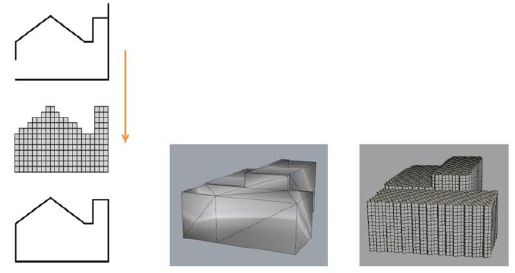
Figure 2 . The voxelization repair concept for 3D building model (Mulder,